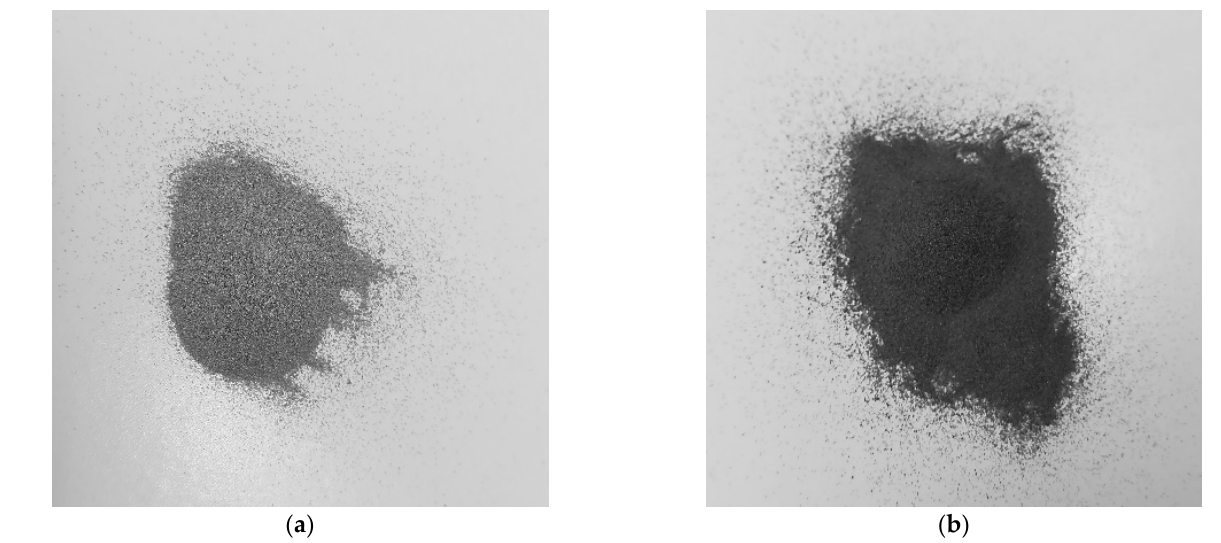
Figure 1. Photograph of inert gas-atomized powders used for laser cladding applications: ( a ) cobalt–chromium–silicon– carbon alloy (Powder 1); ( b ) tungsten carbide–nickel alloy (Powder 2).